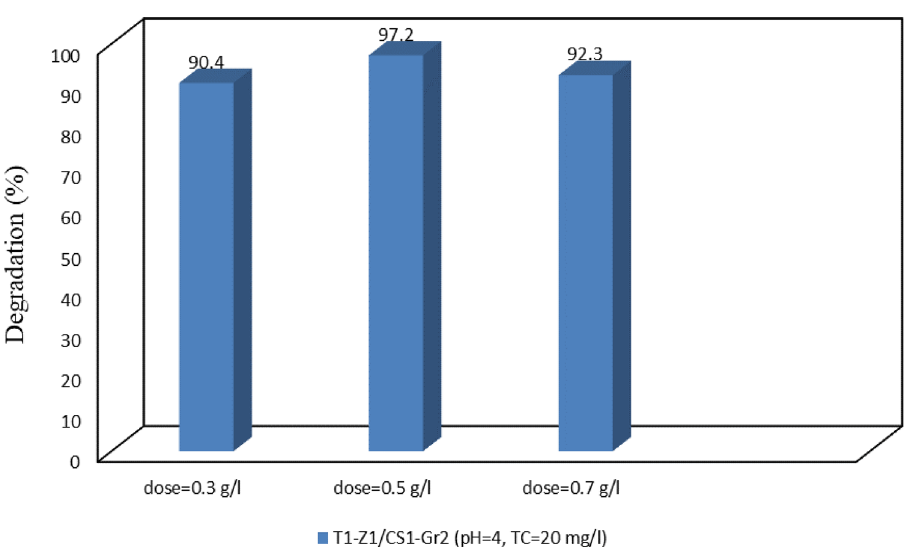
Figure 11. Photodegradation of TC at the optimized solution with different catalyst dosage.